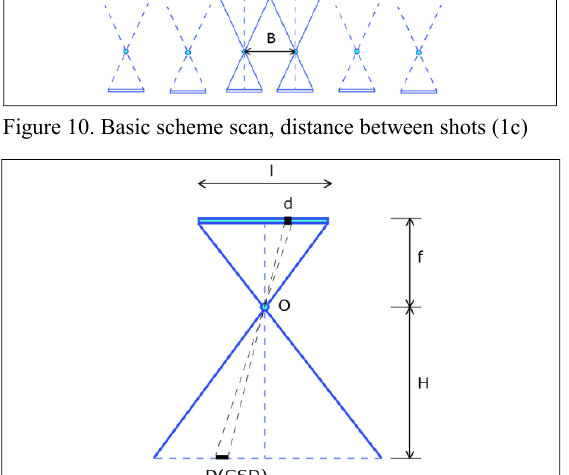
Figure 11. Remote sampling scheme on the ground